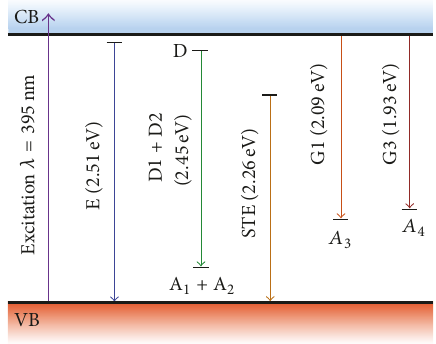
Figure 6: The energy scheme of the optical transitions which are associated with different radiative recombination processes in PbCdI 2 thick films.